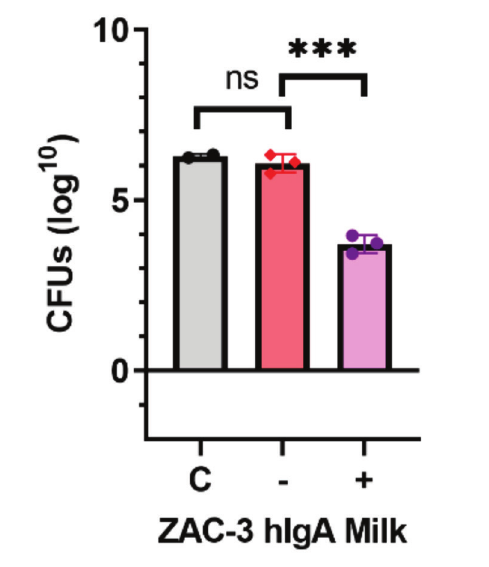
Figure 4. Pups Passively Transferred Diluted ZAC-3 hIgA-Containing Milk Exhibit Significant Re- duction in V. cholerae O395 Colonization. BALB/c pups, 5 days old, were orally gavaged with 1 × 10 7 V. cholerae O395 cells premixed with a 1:100 dilution of milk from a control mouse, m137, or milk from a mouse secreting ZAC-3 hIgA1, m172. There was no significant difference in log CFUs between pups fed only V. cholerae alone or pups fed V. cholerae mixed with control milk from m137. There was a significant reduction in CFUs between pups fed V. cholerae mixed with control milk and those fed with milk from m 172. Suggesting milk from m172 alone, which contains ZAC-3 hIgA1, can decrease colonization of V. cholerae O395. This experiment was done once, with 2 to 3 pups per experimental group as indicated on graph. Statistical significance was determined using 1-way ANOVA followed by Tukey’s multiple compari- son test, *** P <